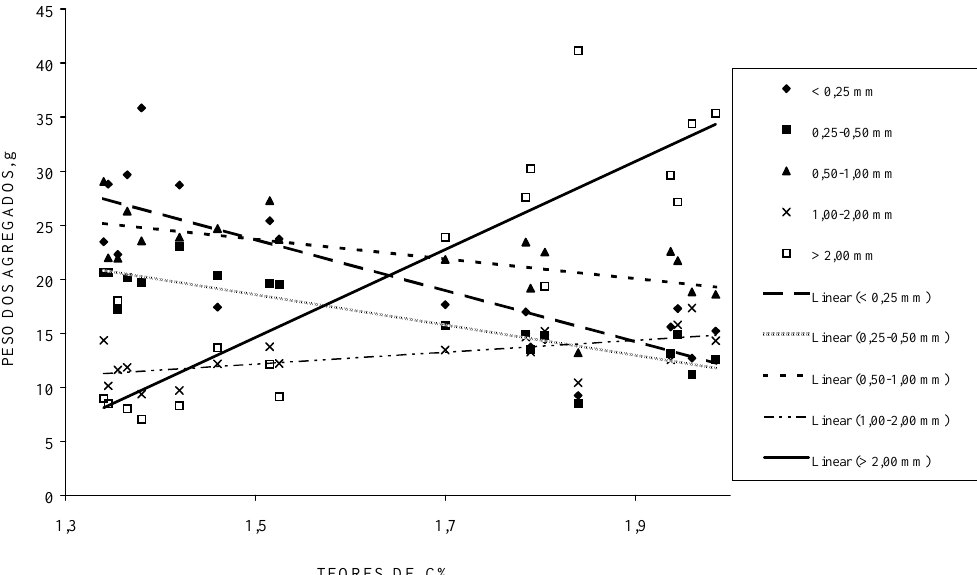
Figura 2. Comportamento das classes de agregados em função dos teores de C-orgânico (0-10